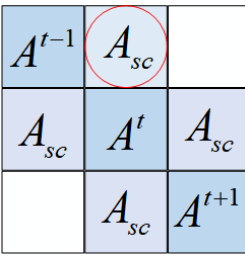
Figure 3. Constructed local spatial-temporal